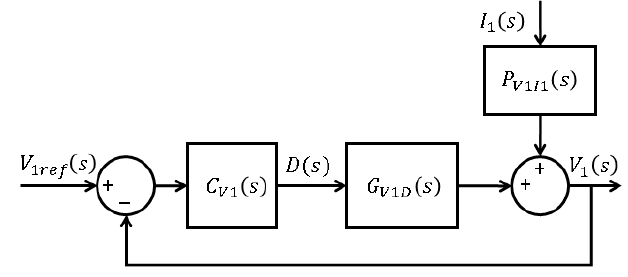
Figure 6. Circuit diagram of the BHBC operating in buck mode.